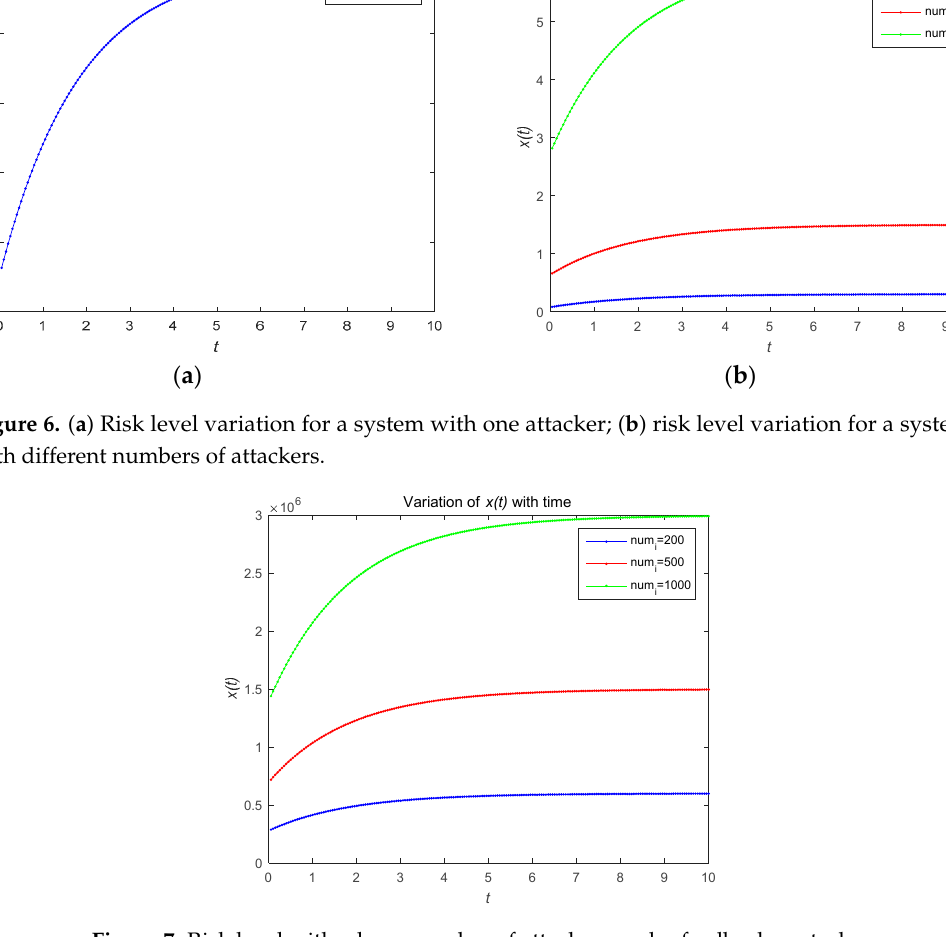
Figure 7. Risk level with a large number of attackers under feedback control.